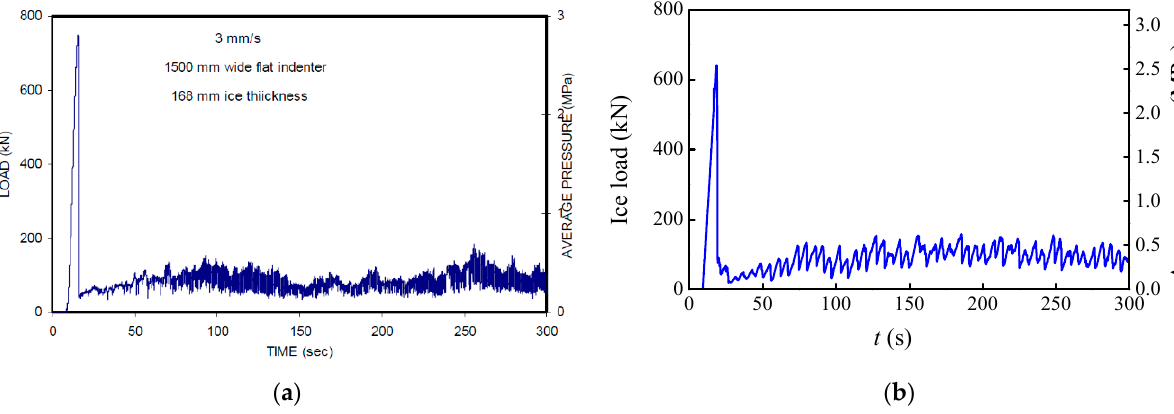
Figure 8. Ice-force curve of the ice–structure interaction: ( a ) field test [27]; ( b ) DEM